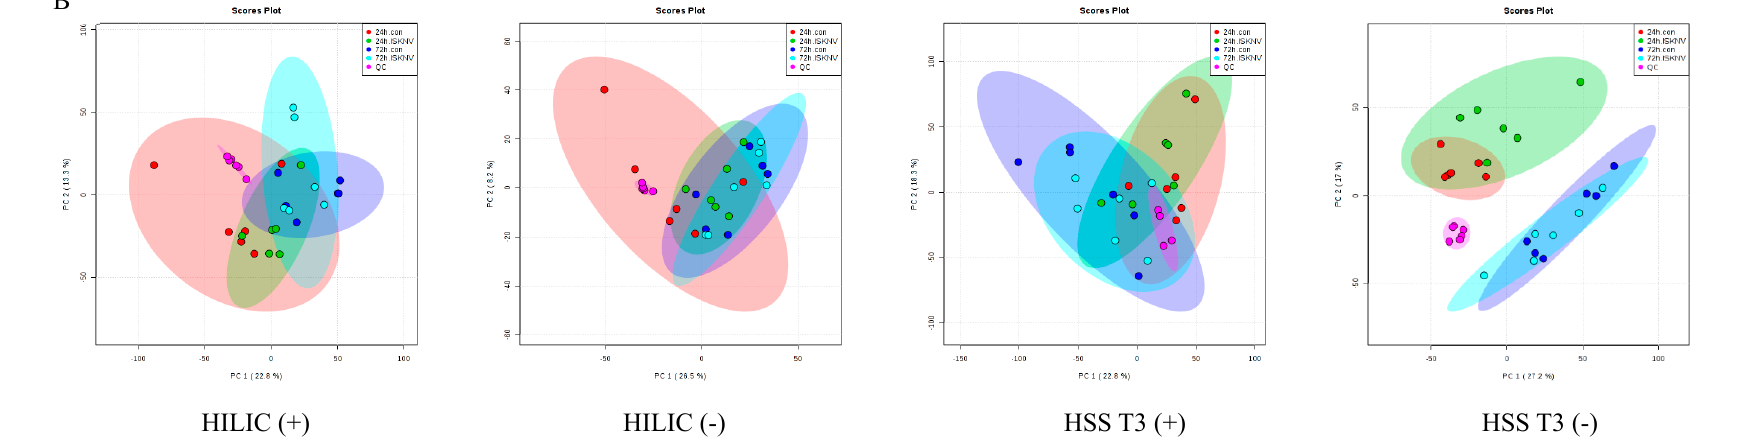
Figure 1. Quality assessment of UHPLC-Q-TOF/MS metabolomics data in CPB cells. ( A ) The distribution of input data values before (left) and after (right) normalization; ( B ) The PCA score plots of Siniperca chuatsi cells sample. Chromatographic columns: ACQUITY BEH Amide 1.7 µm [HILIC] and ACQUITY HSS T3 1.8 µm [HSS T3]. Abbreviations: (+) positive ion modes; ( − ) negative ion modes.